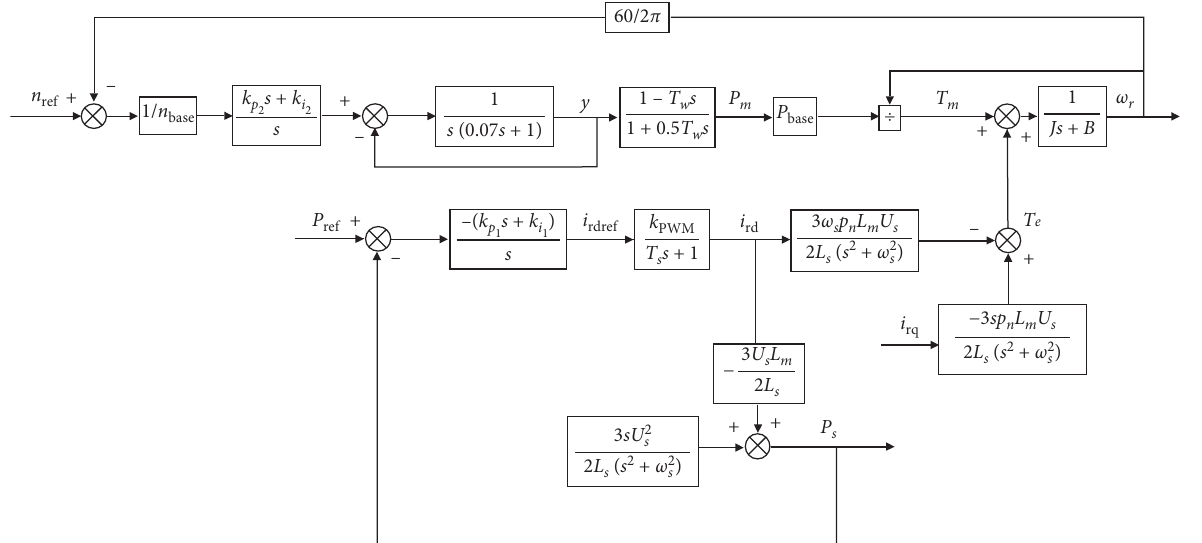
Figure 7: Control block diagram of the power priority control strategy in generating mode.